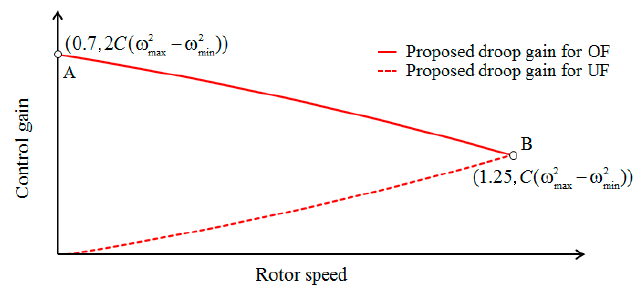
Figure 4. Droop characteristics of the proposed frequency control method.